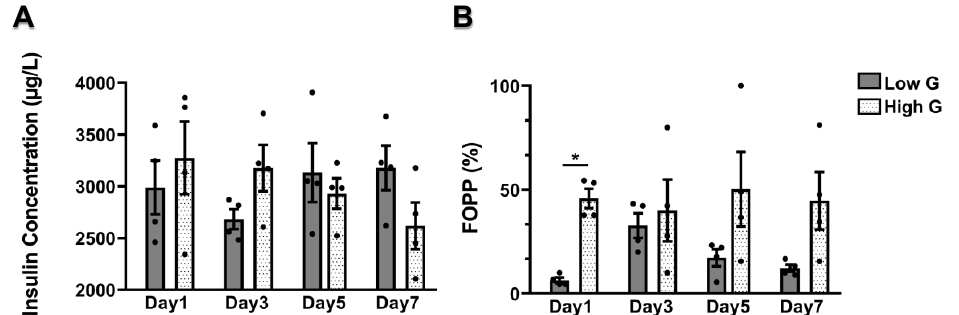
Figure 4. Assessment of insulin secretion and fraction of the plateau phase (FOPP). ( A ) Mean insulin concentration under static incubation of 4 released by dissociated islets on MEAs in low (1.1 mM) and high (16.7 mM) glucose media for different culture days ( n = 4 MEAs for each condition). ( B ) Quantification of the mean FOPP measured by MEAs with dissociated islets in response to low (1.1 mM) and high (16.7 mM) glucose media for the different culture days ( n = 4 MEAs for each condition). * p < 0.05.